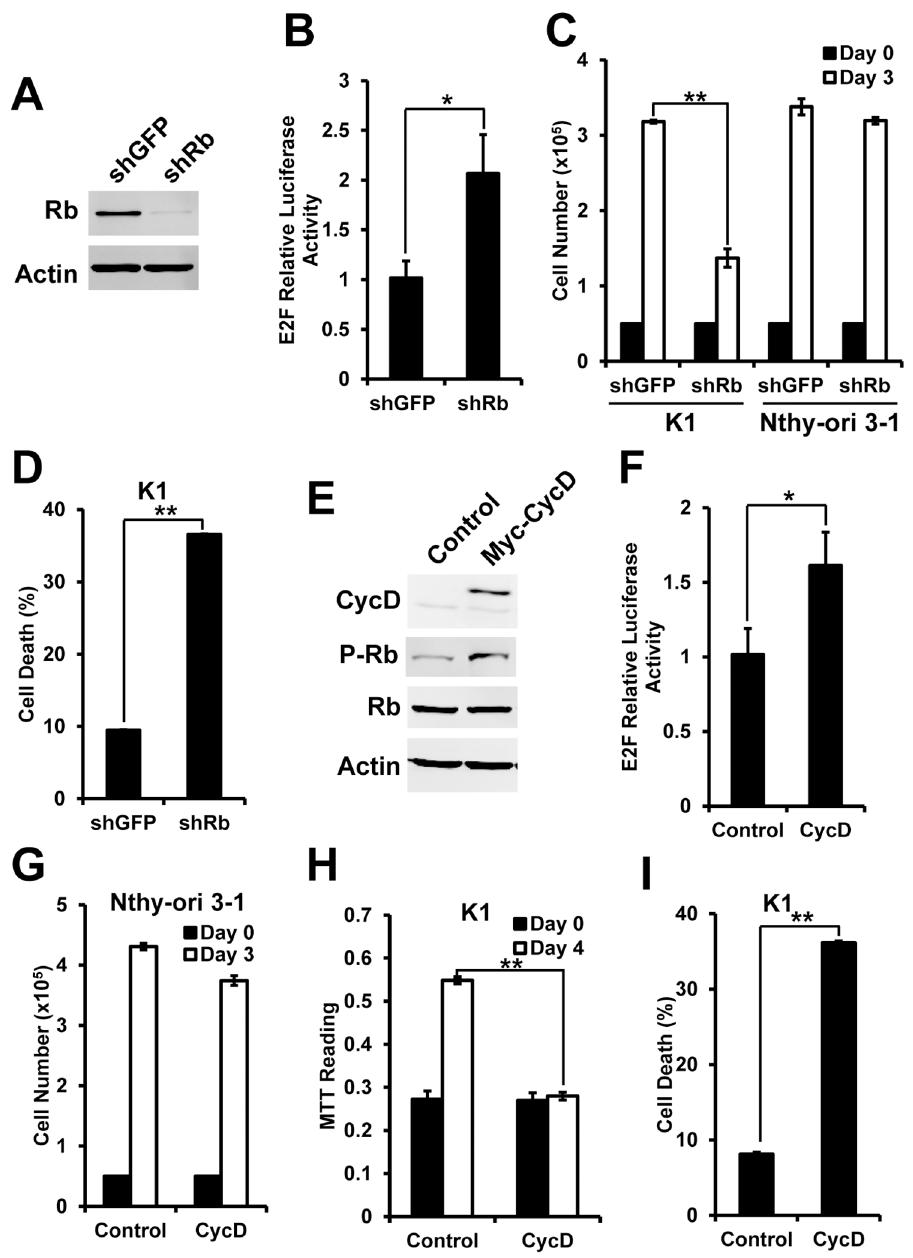
Fig 3. Enhanced E2F activity induced cell death in K1 cells. (A) Immuno blot showeddecreased Rb level in cells with knockdown of Rb. Actin serves as a loadingcontrol; (B) E2F activity reporter showedknockdown of Rb increasedE2F activity; (C) Cell growth was measured in Nthy-ori 3–1 and K1 cells with knockdownof Rb; (D) Cell death was measuredin K1 cells with knockdown of Rb by AnnexinV and PI assay; (E) Immuno blot showedoverexpression of Cyclin D1 and increasedlevel of phosphor-Rb. Rb and Actin serves as loading controls; (F) E2F activity reporter showedoverexpression of Cyclin D1 increasedE2F activity; (G) and (H) Cell growth was measuredin Nthy-ori 3–1 (G) and K1 cells (H) with overexpression of CyclinD1; (I) Cell death was measuredin K1 cells with overexpression of Cyclin D1 by AnnexinV and PI assay on Day 4. * < 0.05, ** <